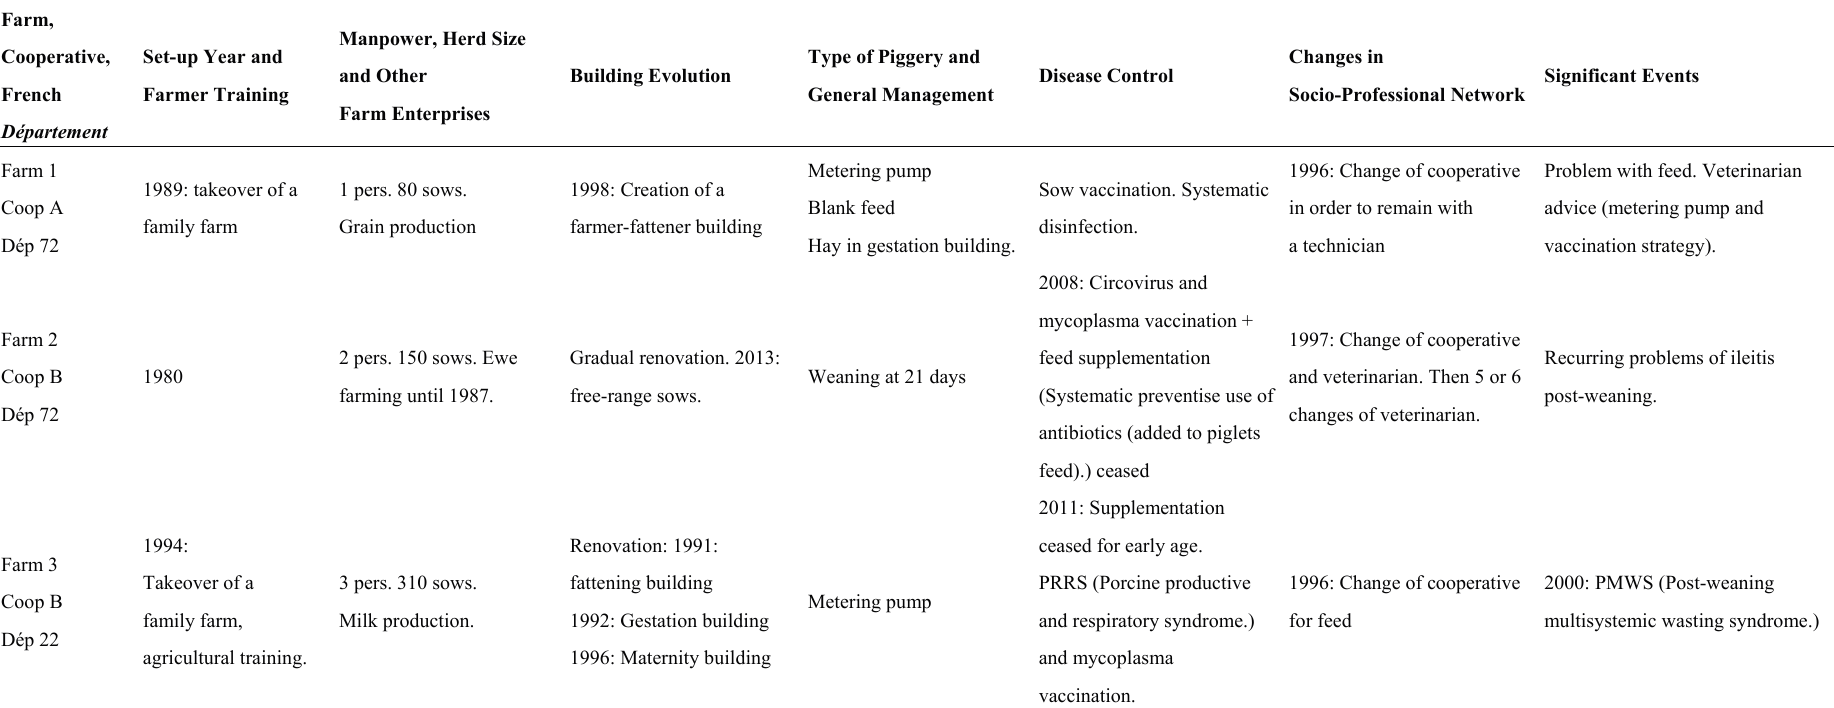
Table 1. Main aspects of trajectories of change in the 11 farms